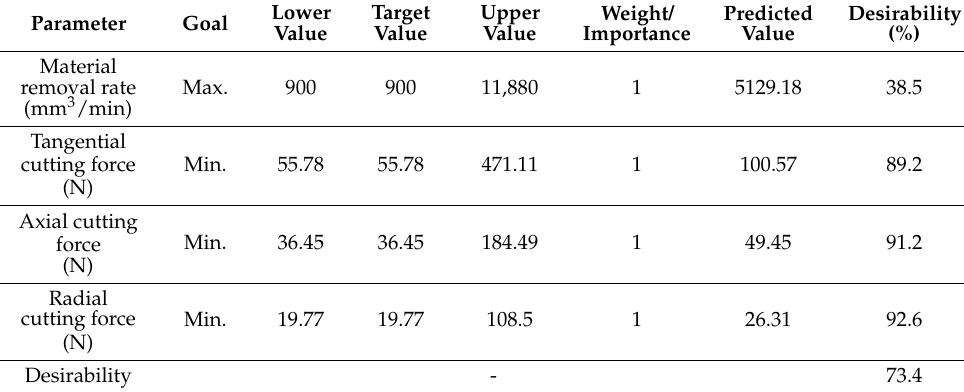
Table 5. Response surface methodology parameter design and predicted responses for both the mono and multiple